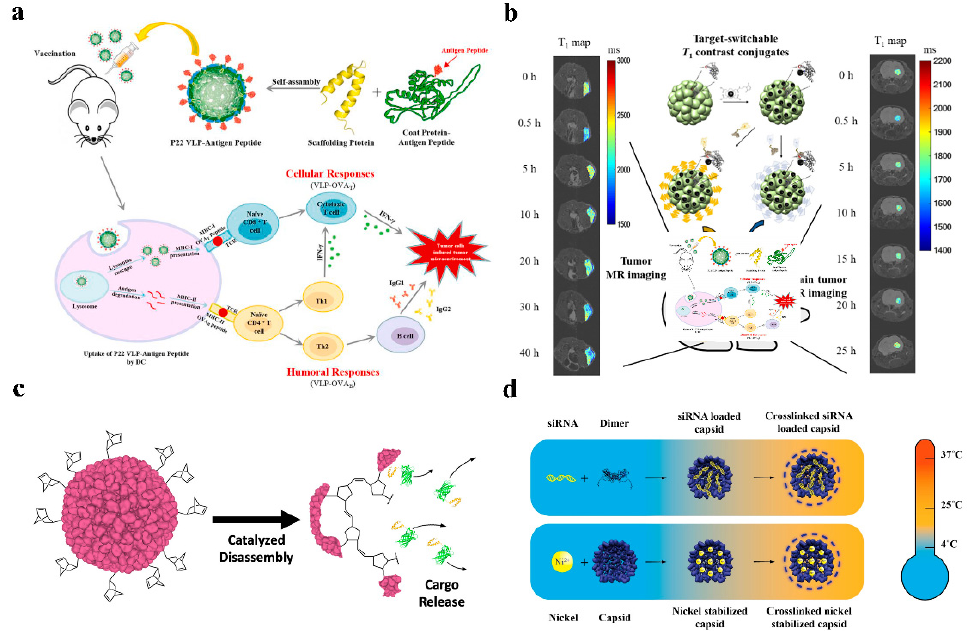
Figure 4. Application of several protein cage NPs. ( a ) P22 VLP-OVA capsid protein efficiently stim-